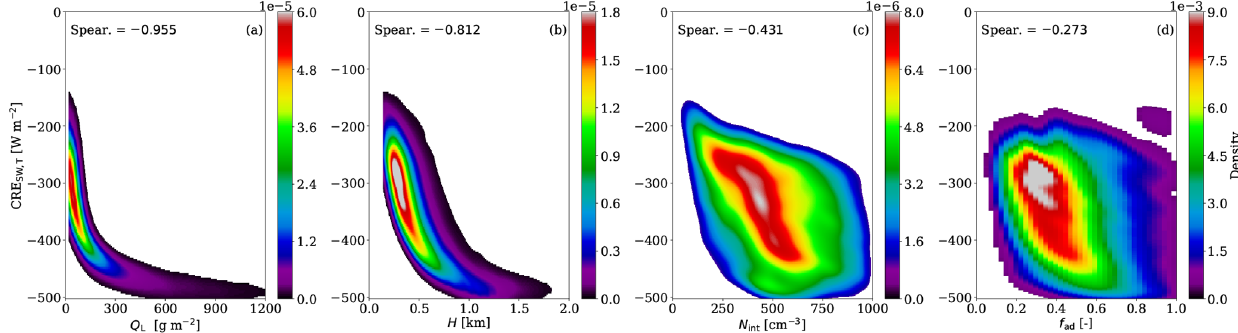
Figure 5. BKD between the reference simulation (ref.) and the cloud properties that are essential for the derivation of the cloud optical thickness, which is one of the fundamental properties describing the SW cloud radiative effect. Panels illustrate the BKD between the CRE SW , T and (a) Q L , (b) H , (c) N int , and (d) f ad . The corresponding Spearman (Spear.) correlations are highlighted.